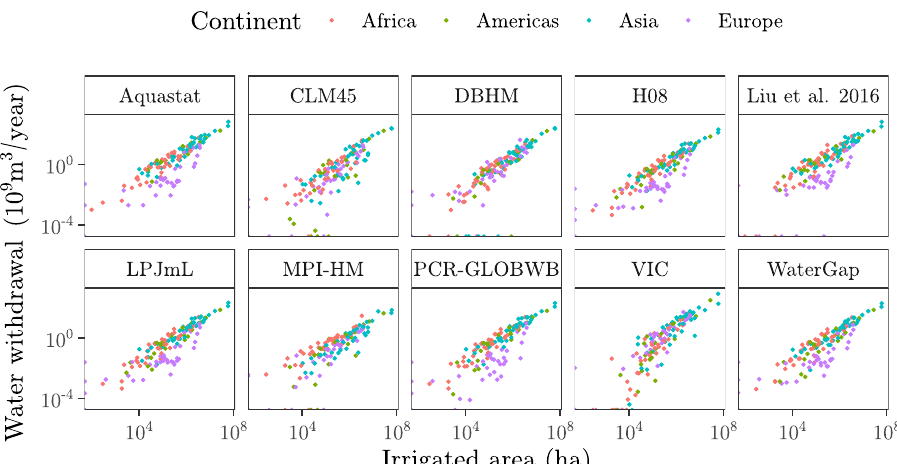
Fig. 1 Scatterplots of irrigated areas against irrigation water withdrawals. Irrigated area data are provided by the FAO-GMIA 37 , which re fl ects the extension of irrigation in 2005. Irrigation water withdrawals are retrieved from GMs (CLM45, DBHM, H08, LPJmL, MPI-HM, PCR-GLOBWB, VIC, WaterGap) and from FAO-based datasets (Aquastat, Liu et al. 19 ). GM data is from 2005 and FAO-based data from 2012. Each dot is a country. The abscissa is x and the ordinate y in Eq. (1) (see Methods).